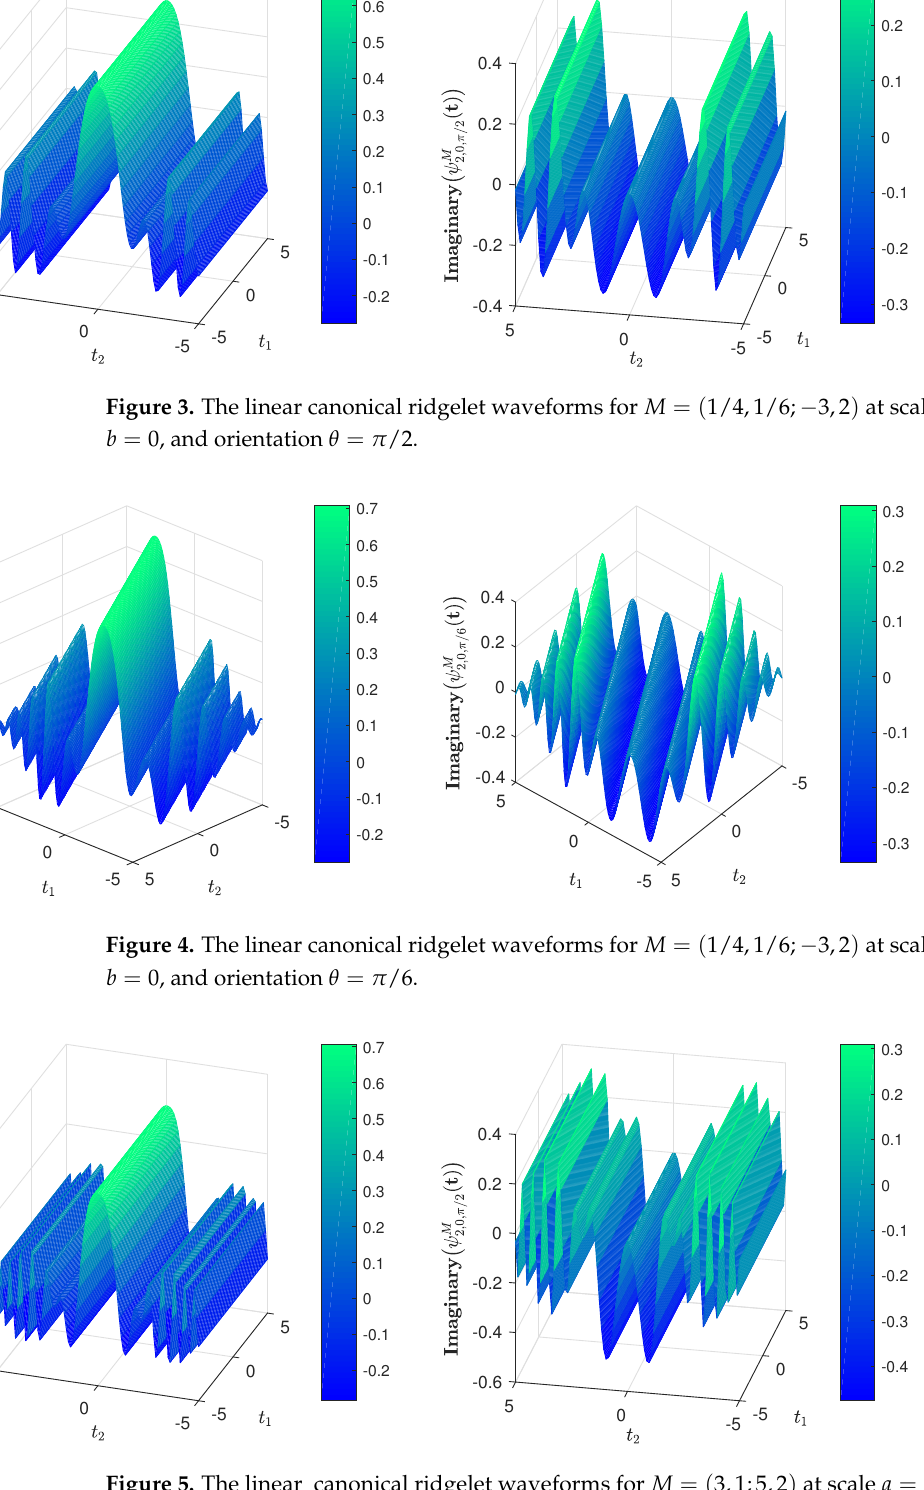
Figure 5. The linear canonical ridgelet waveforms for M = ( 3,1;5,2 ) at scale a = 2, location b = 0, and orientation θ = π